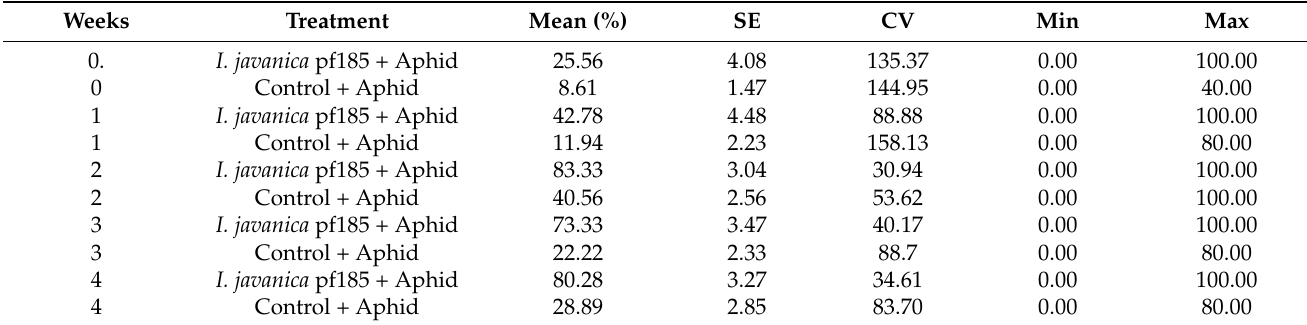
Table 2. Weekly mortality per treatment during assessment of aphicidal activity.